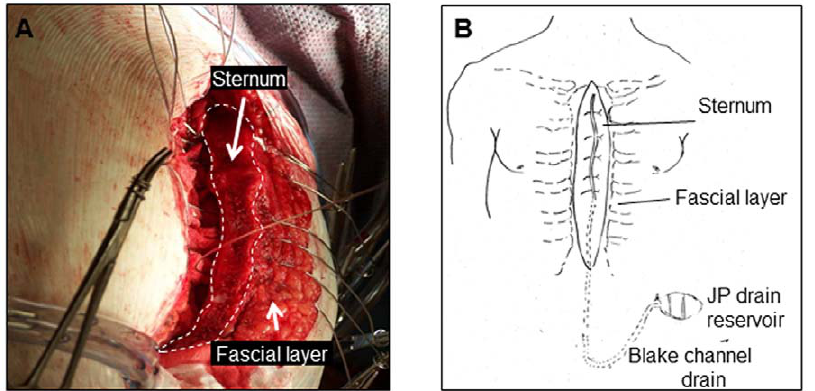
Figure 1. Fluid and cell collection from sternal wound environment. A , image of the sternal wound before closure where the Blake drain is yet to be placed; B , after closure of the sternum, the surgeon placed a Blake drain over the sternum, and then closed the wound in layers. The Blake drain was connected to a heparinized J-VAC bulb suction reservoir for wound fluid collection.